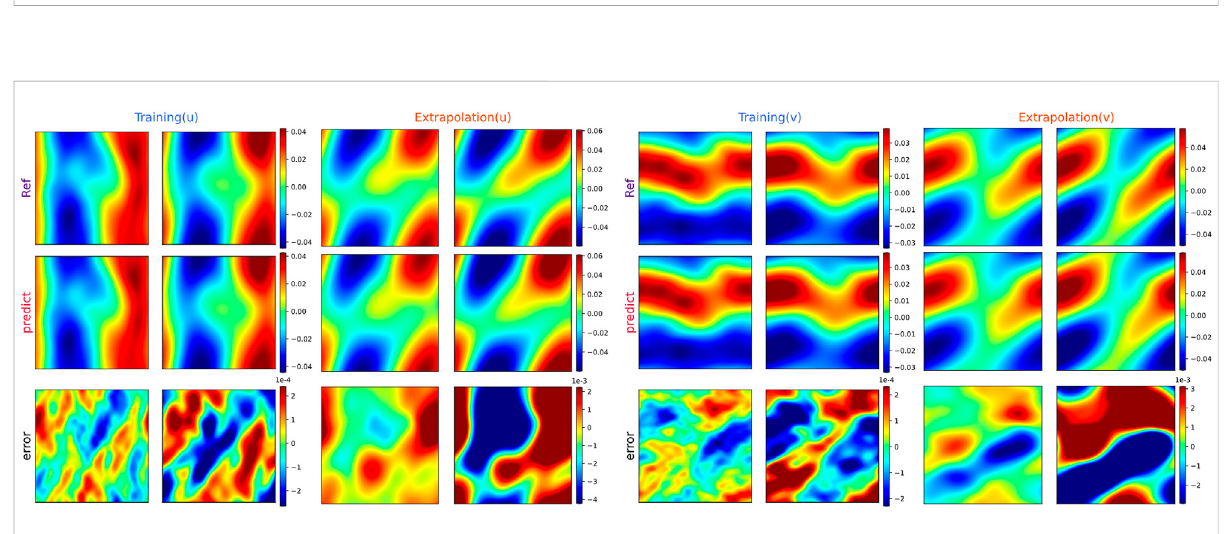
The velocity fi eld results of Fourier fi lter-based PhyCRNet solving the 2D N_S equation. Four representative time instants are selected as comparisons, namely training (t = 0.5, 1.5 s) and extrapolation (t = 2.5, 3.5 s), and compare the errors of the whole interval one by one. From top to bottom are reference solutions, predictions and